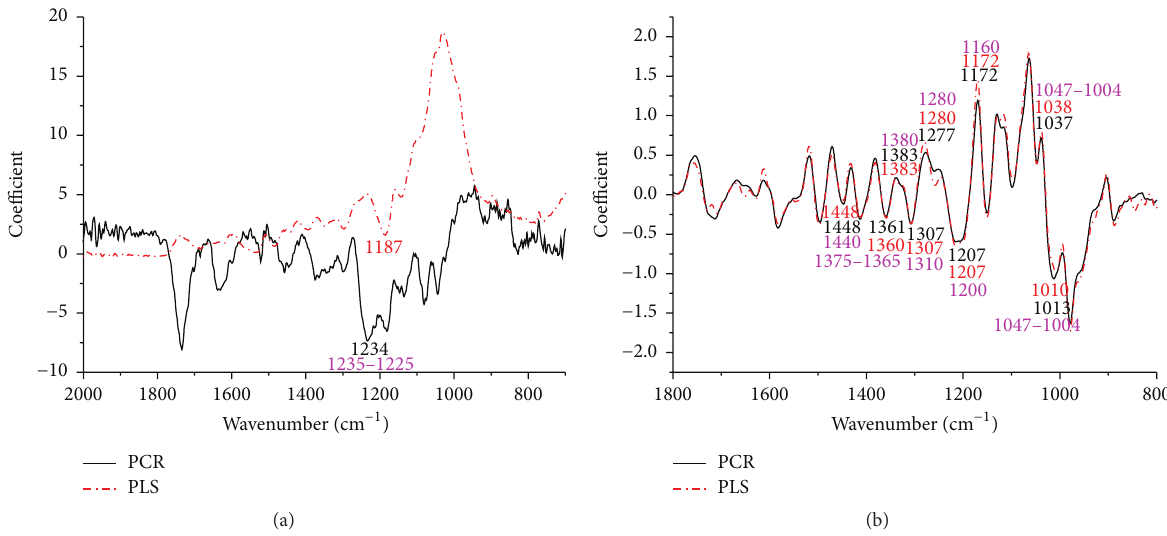
Figure 4: Coefficients by wavenumber for PCR and PLS for cellulose prediction (a) when raw spectra were processed and (b) when a first- derivative pretreatment was processed. PC numbers 8, 3, 1, and 2 were chosen for PCR-raw, PLS-raw, PCR-derivative, and PLS derivative, respectively ( 𝛼 = 0.05 ).